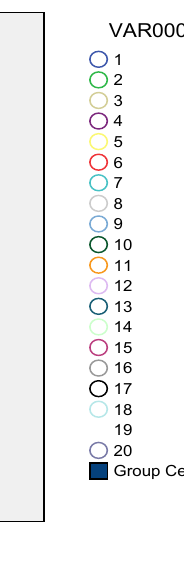
Fig. 1. Canonical disriminant analyses of local maize populations by grain yield and quality